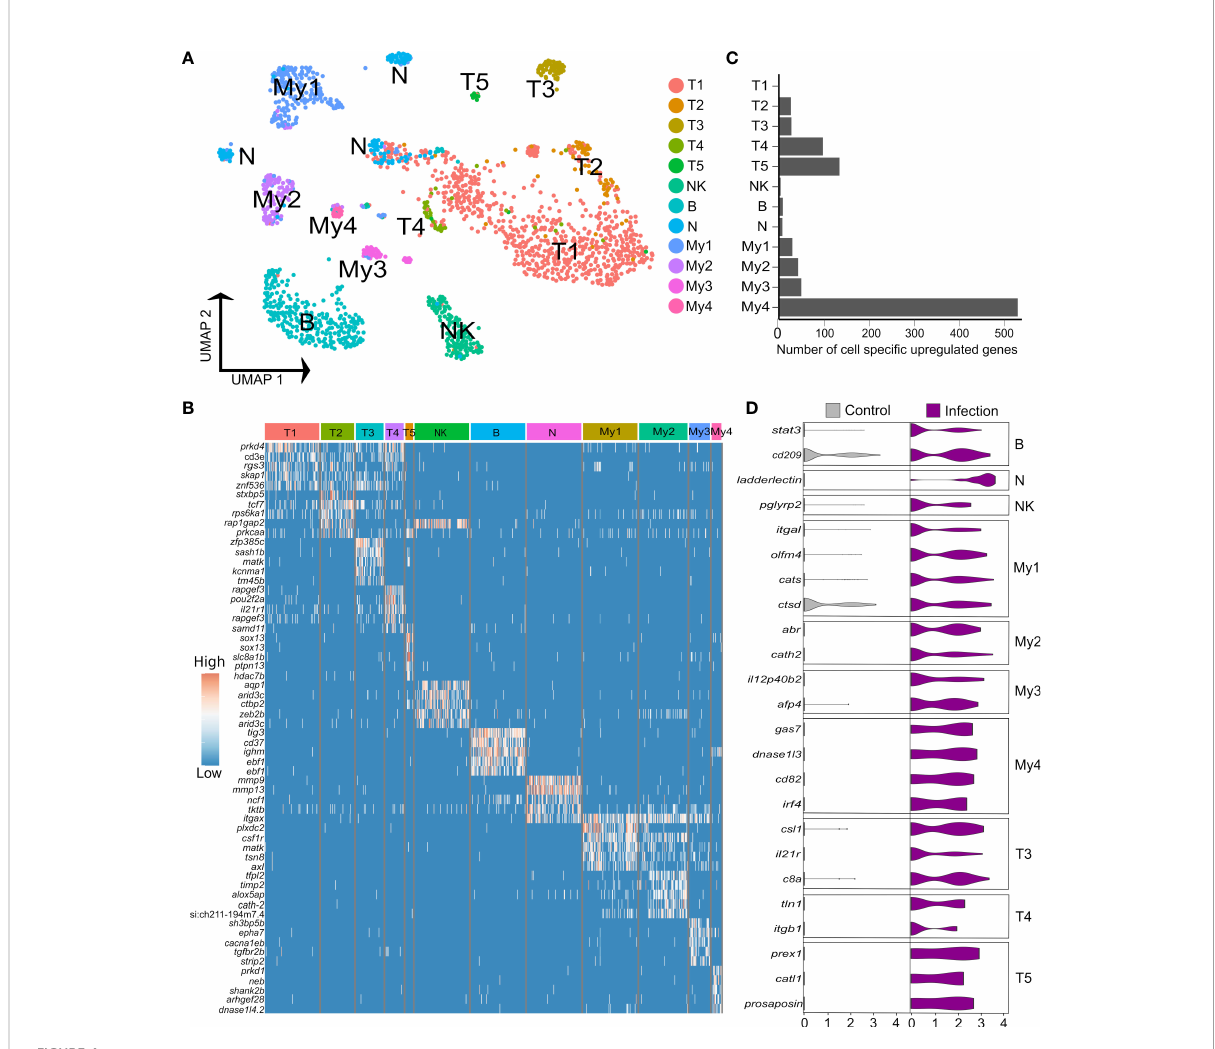
FIGURE 4 Heterogeneity in Atlantic salmon immune cells. (A) UMAP visualization of 1,620 immune nuclei. (B) Heatmap of top 5 markers genes for each immune sub-cluster, sorted by log2 fold change. (C) Number of cell-speci fi c genes up-regulated by infection in immune sub-clusters (D) Examples of genes showing cell-speci fi c up-regulation in response to Aeromonas infection across the breath of immune cell heterogeneity identi fi